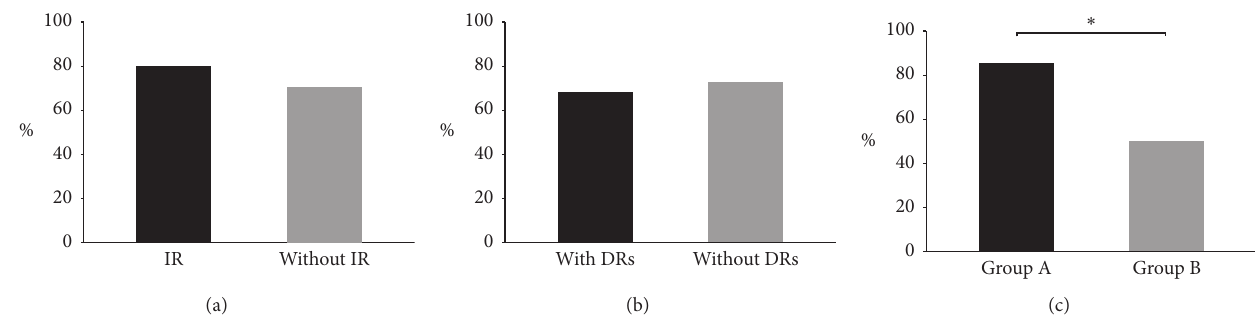
Figure 1: Percentages of women who reported an improvement of menstrual regularity after the treatment. (a) Women with insulin resistance (IR) reported similar changes of menstrual cyclicity than those without IR. (b) Women with diabetic relatives (DRs) reported similar changes of menstrual cyclicity than those without DRs. (c) A higher percentage of women of group A (2000mg of MI+800mg of ALA) reported an improvement of menstrual cyclicity than those of group B (1000mg of MI+800mg of ALA). ∗ p < 0 . 01 (group A vs. group B). Table 3: Results of the treatment in two subgroups of women taking the same dose of ALA (800 mg) and two different doses of MI per day (group A 2000 mg; group B